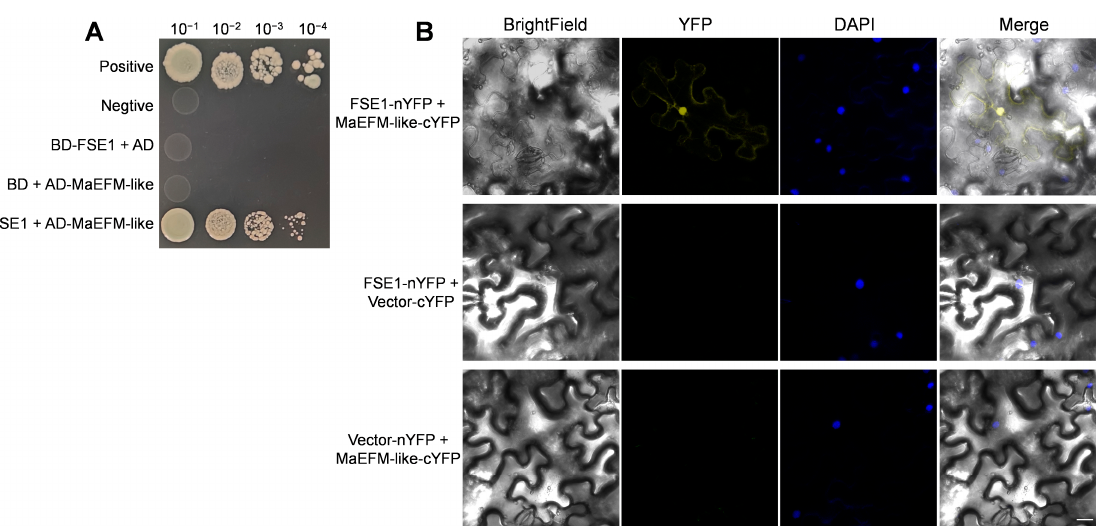
Figure 6. Verifying interaction between FSE1 and MaEFM-like. ( A ) Yeast two-hybrid (Y2H) assays showing FSE1 interact with MaEFM-like. Yeast cell were grown on SD/-Trp-Leu-His-Ade plates containing 125 ng mL − 1 aureobasidin A (ABA). ( B ) BiFC analysis of in planta interaction between FSE1 and MaEFM-like in N. benthamiana epidermal cells. DAPI, 4 ′ ,6-diamidino-2-phenylindole. Scale Bar = 25 μ m.